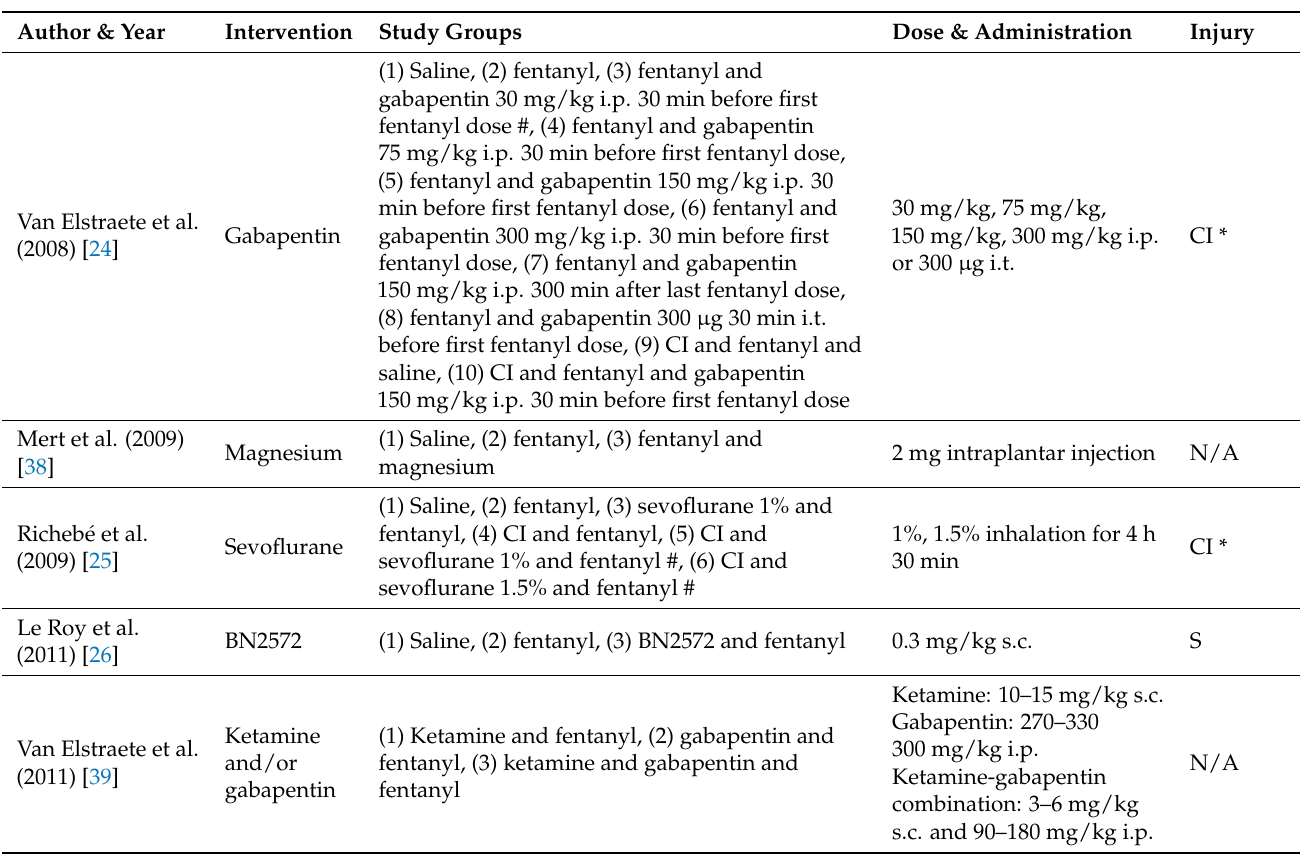
Table 3. Main characteristics of morphine trials. Intervention, study groups, intervention dose, administration method, and opioid regimen (chronic/acute) used in 31 trials. #: experimental group was not statistically different from the opioid only group. i.v. = intravenous. s.c.: